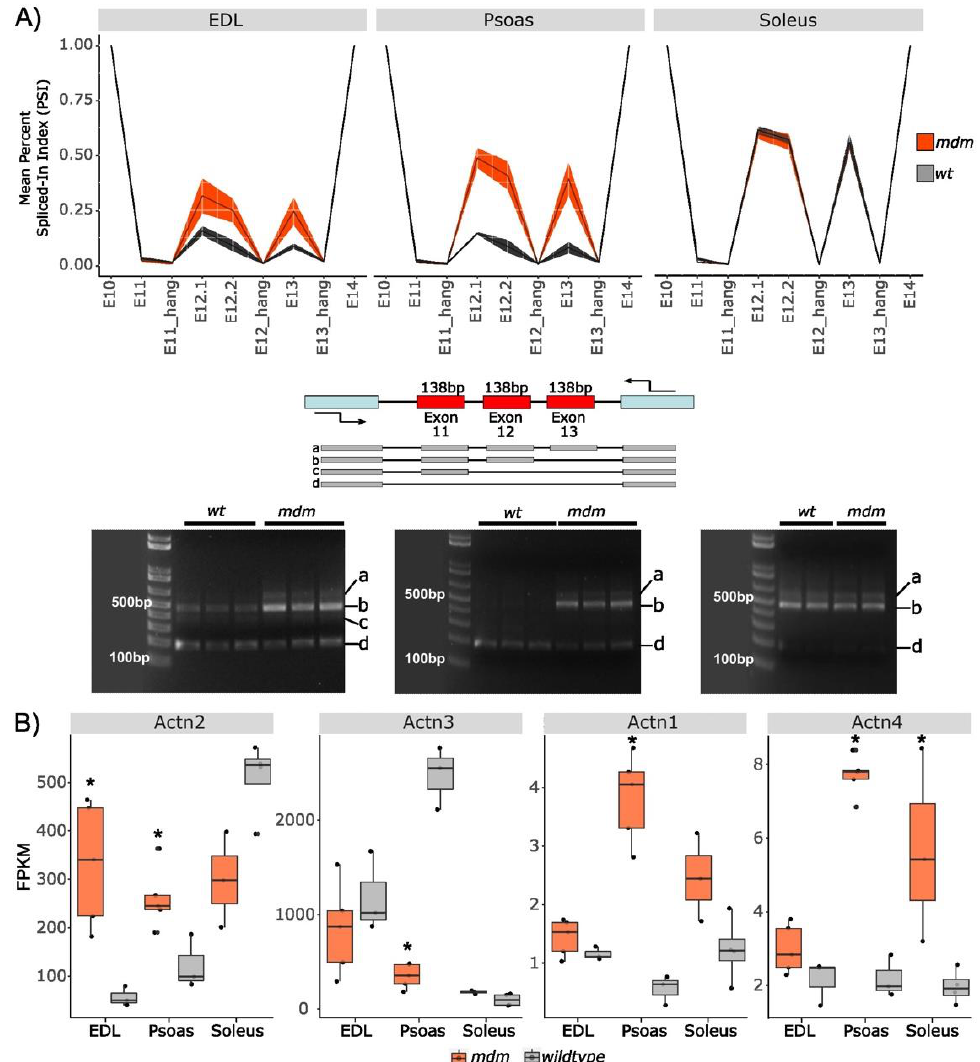
Figure 1. Fast mdm muscles (red) expressed more Z-repeats compared to WT muscles (gray). ( A ) Percent spliced-in (PSI) indexes calculated for exons 10 – 14 using RNA-Seq data (top row), and agarose gel images for amplification of exons 11 – 13 using primers annealed on flanking exons (bottom row). Expression of exons 12 and 13 encoding Z-repeats 5 and 6 was upregulated in mdm EDL and psoas muscles compared to WT muscles (two-way ANOVA, all p < 0.0001). PSI index varies from 0 = complete exclusion to 1 = complete inclusion of exons in the transcript pool. Exon labels are suffixed with a period followed by a number if the region was split into separate segments based on the variable distribution of reads in the alignments. Segments flanking annotated exon boundaries are suffixed with “_hang”. The shaded areas show the standard deviation of mean PSI values. Illustration shows the primer locations with arrows and exon arrangement in the region of interest. Agarose gel images show four variants: (a) expression of exons 11–13 (599 bp); (b) exclusion of one exon (461 bp); (c) exclusion of two exons (323 bp); and (d) complete exclusion of exons 11–13 (185 bp). ( B ) Expression of α -actinin1–4 in mdm muscles compared to WT muscles. Data were plotted as FPKM (fragments per kilobase of transcript per million mapped reads). * Indicates mdm to wild-type expression differences significant at the 99% level as calculated by